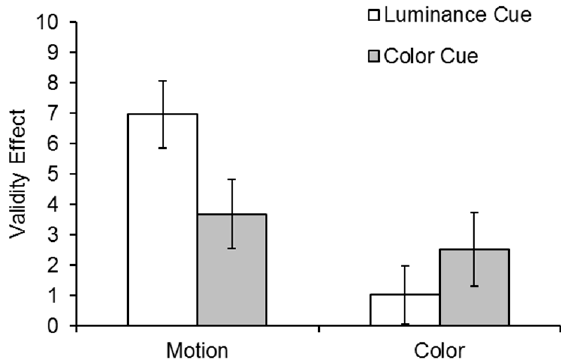
Figure 3. Validity effects in the motion and color discrimination tasks were calculated by subtracting the percent correct on uncued trials from percent correct on cued trials. White bars represent the validity effect following a luminance cue, and grey bars represent the validity effect following a color cue. Error bars represent standard error of the means.